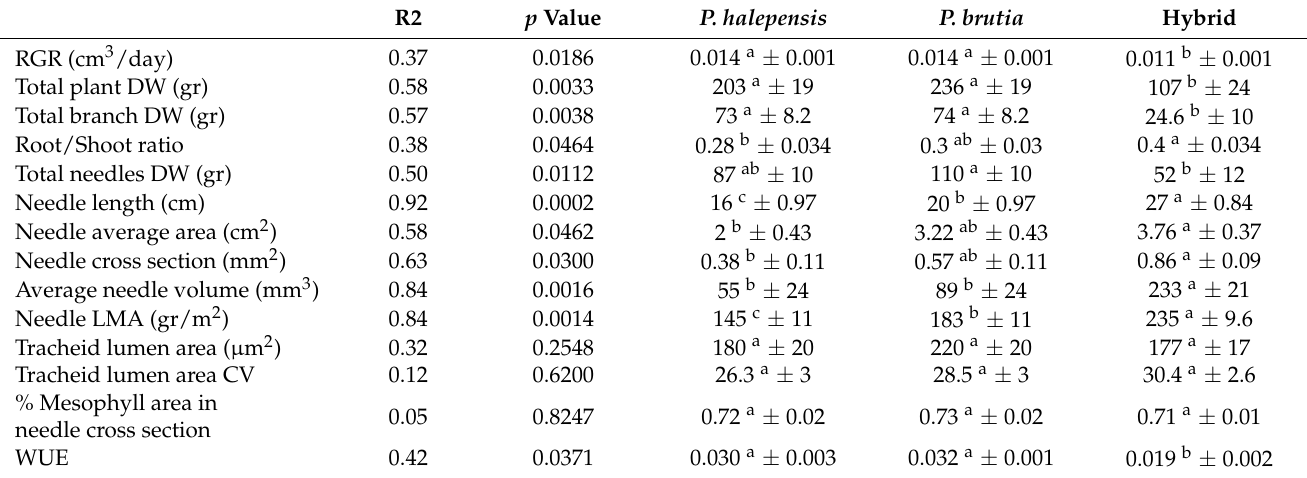
Table 1. One-way ANOVA of the effect of P. halepensis , P. brutia , and their hybrids on morphological and growth parameters and on WUE. Data are the means of six plants of each of P. halepensis and P. brutia , and four hybrids ± standard error. Different superscript letters indicate significant differ- ences between the various genotypes ( p <